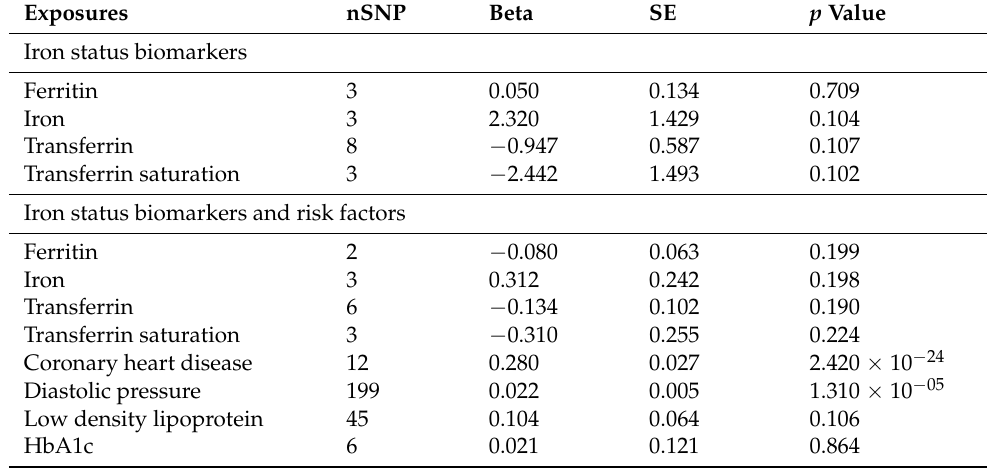
Table 3. Assessing the causal association between iron status and HF using IVW multivariate